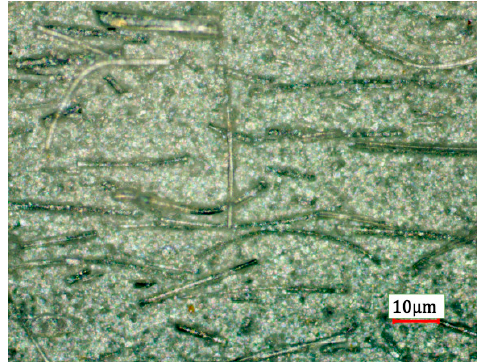
Figure 3. The fibers were evenly dispersed in the slurry.